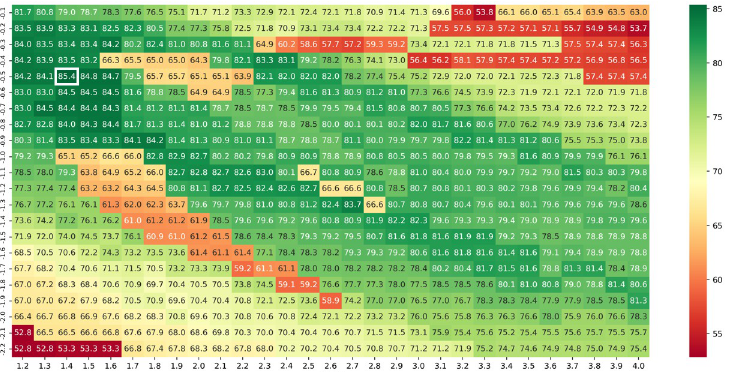
Fig 5. Cross validation results. For each possible combination of the intercept and slope, the value within the grid represents the geometric mean of the sensitivity and positive predictive value over 30 values of results from 29 RNA (each of the 30 RNA left out exactly once). Final result is the average of averages using a leave-one out scheme to avoid bias toward any one RNA. Optimal parameters identified by white box: intercept − 0.5, slope 1.4. Color indicates performance relative to optimal with darker green as the best and red as the worst performance.